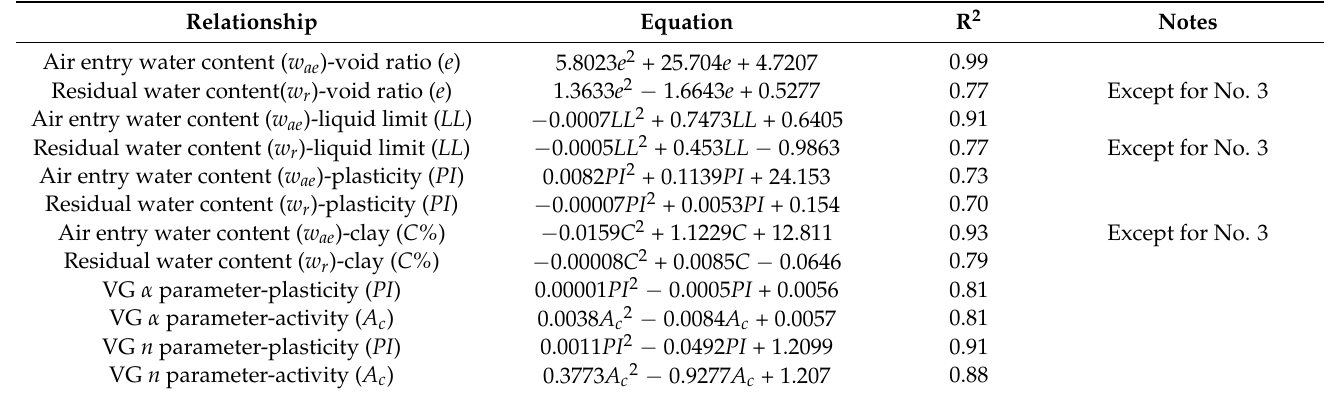
Table 5. Correlations of SWCC parameters with soil